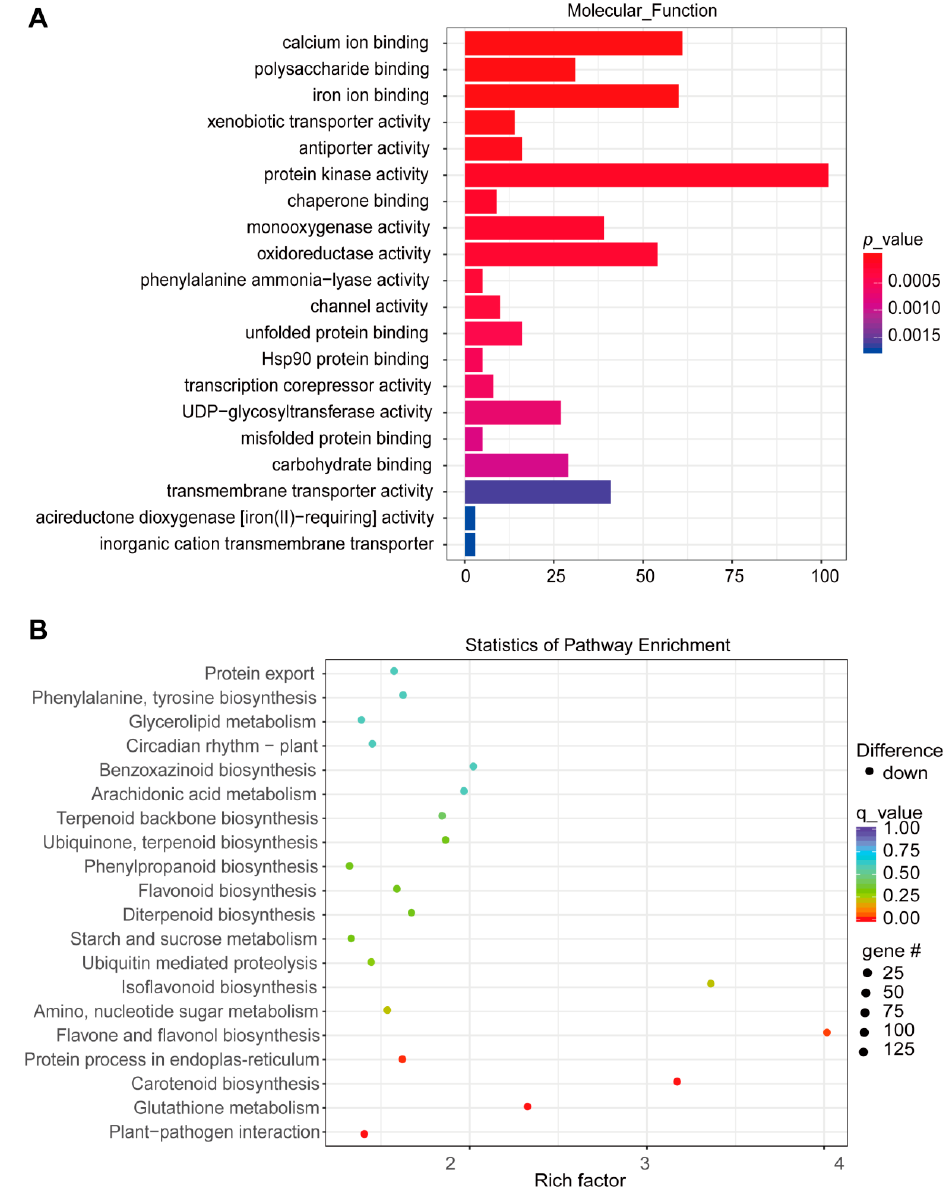
Figure 5. GO and KEGG analysis of upregulated genes in LD10 relative to BX at 10 DAT. ( A ) Molecular function extracted from GO analysis of the list of upregulated genes. ( B ) KEGG analysis of the list of upregulated genes.